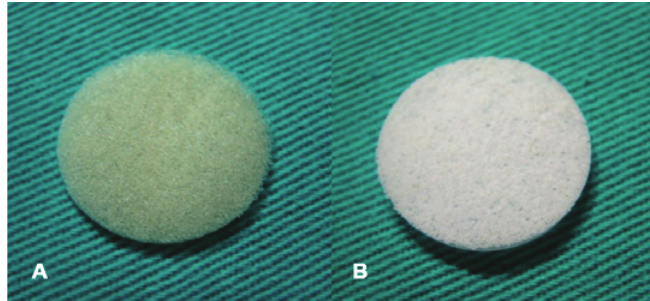
FIGURE 1 – Implants. A. Polyurethane. B. Silicone.